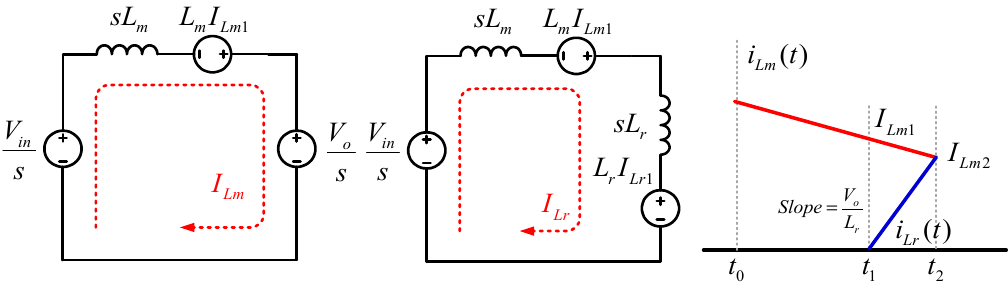
4 of 19 Figure 4. Equivalent circuit of Mode 1 and key waveform. Mode 1 ( t 0 –t 1 ): Main S 1 and auxiliary switches S 2 and S 3 are turned off. The accumulated main inductor current L m is flowed through the output diode D o . Then, output and resonant capacitors C o C r are charged the same voltage. Equivalent circuit of mode 1 and key waveform is shown in Figure 4. The equivalent circuit shows when the main inductor discharges for boost. In Mode 1, the main inductor current i Lm decreases and the resonant inductor current i Lr and auxiliary capacitor voltage v Ca are zero. This is expressed as the Equations (1) and (2). 10